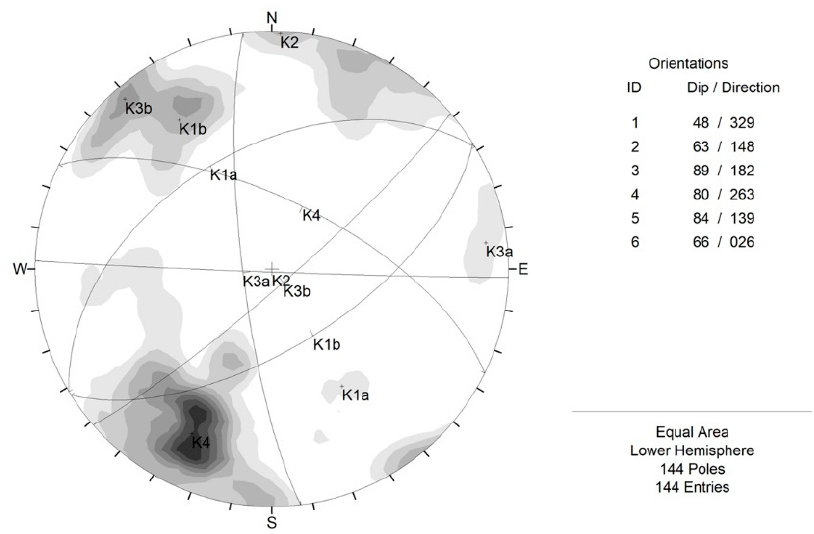
Figure 6. Example of a plot of a single window and the relative sets. Table 3. Number of discontinuities surveyed in each window.